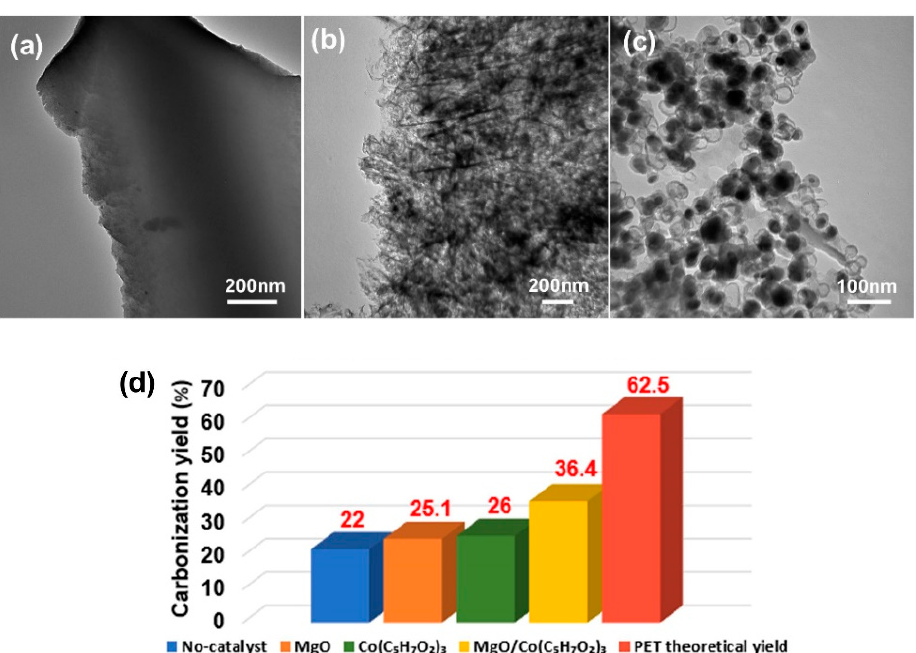
Figure 2. TEM images of ( a ) Carbon prodcut from neat PET, ( b ) Carbon sample prepared from PET/MgO, ( c ) Carbon sample from PET/Co(acac) 3 and ( d ) the corresponding carbon yields from different catalyst.